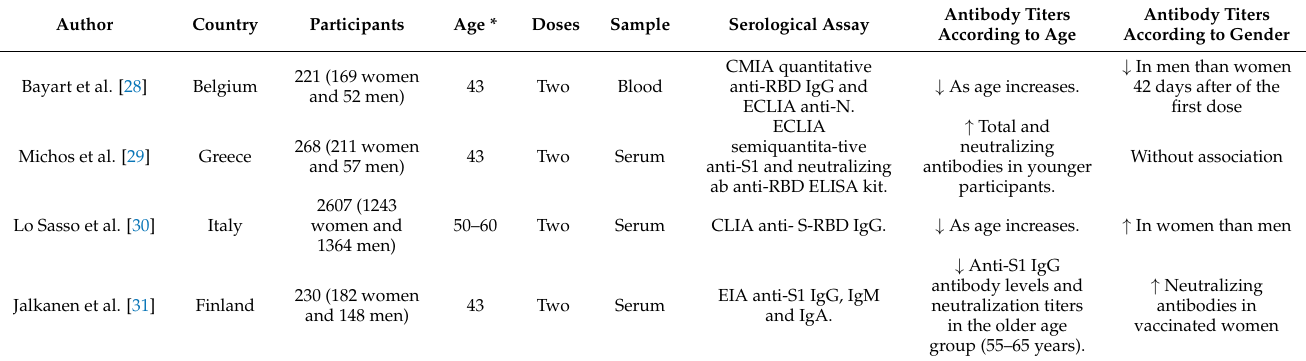
Table 2. Effect of age and gender on the antibody response induced by the BNT162b2